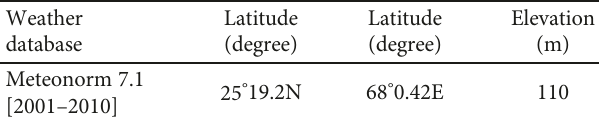
Table 1: The coordinates and elevation are